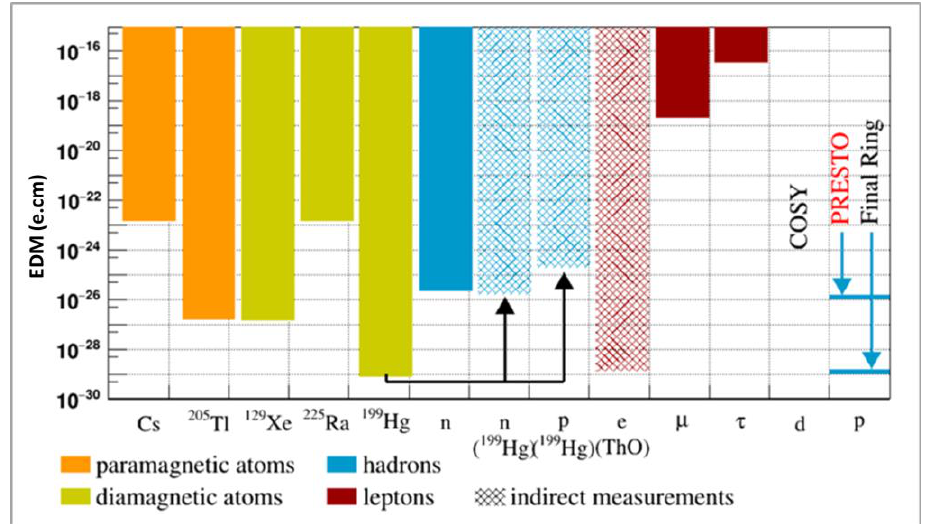
Figure 1. Current status of EDM searches (95% upper limits) of molecules, atoms, and particles: the full-colour bars represent direct measurements, while the shaded bars are deduced results for these systems. In particular, the proton result has been obtained indirectly from the experimental EDM limit for 199 Hg; this is indicated by the black arrows. Impressive EDM limits for the electron come from Thorium-oxide (ThO) and HfF + measurements [9] — still many orders of magnitude larger than the SM-prediction. It generally holds that the contribution from the SM is negligible at the sensitivity level accessible with current experimental techniques. For the deuteron (d), for which neither a direct nor an indirect limit is known, an EDM limit from the measurement at the Cooler Synchrotron (COSY) of Forschungszentrum Jülich (Germany) will soon be available (see below). The expected sensitivity is comparable to the muon (µ) [19] and tau (τ) limits [20 ]. The goal of the proton EDM (p) of the final ring is to reach a sensitivity of 10 − 29 e.cm, and the goal for the intermediate step — a prototype storage ring (called PRESTO in the figure) — is to reach 10 −26 e.cm.